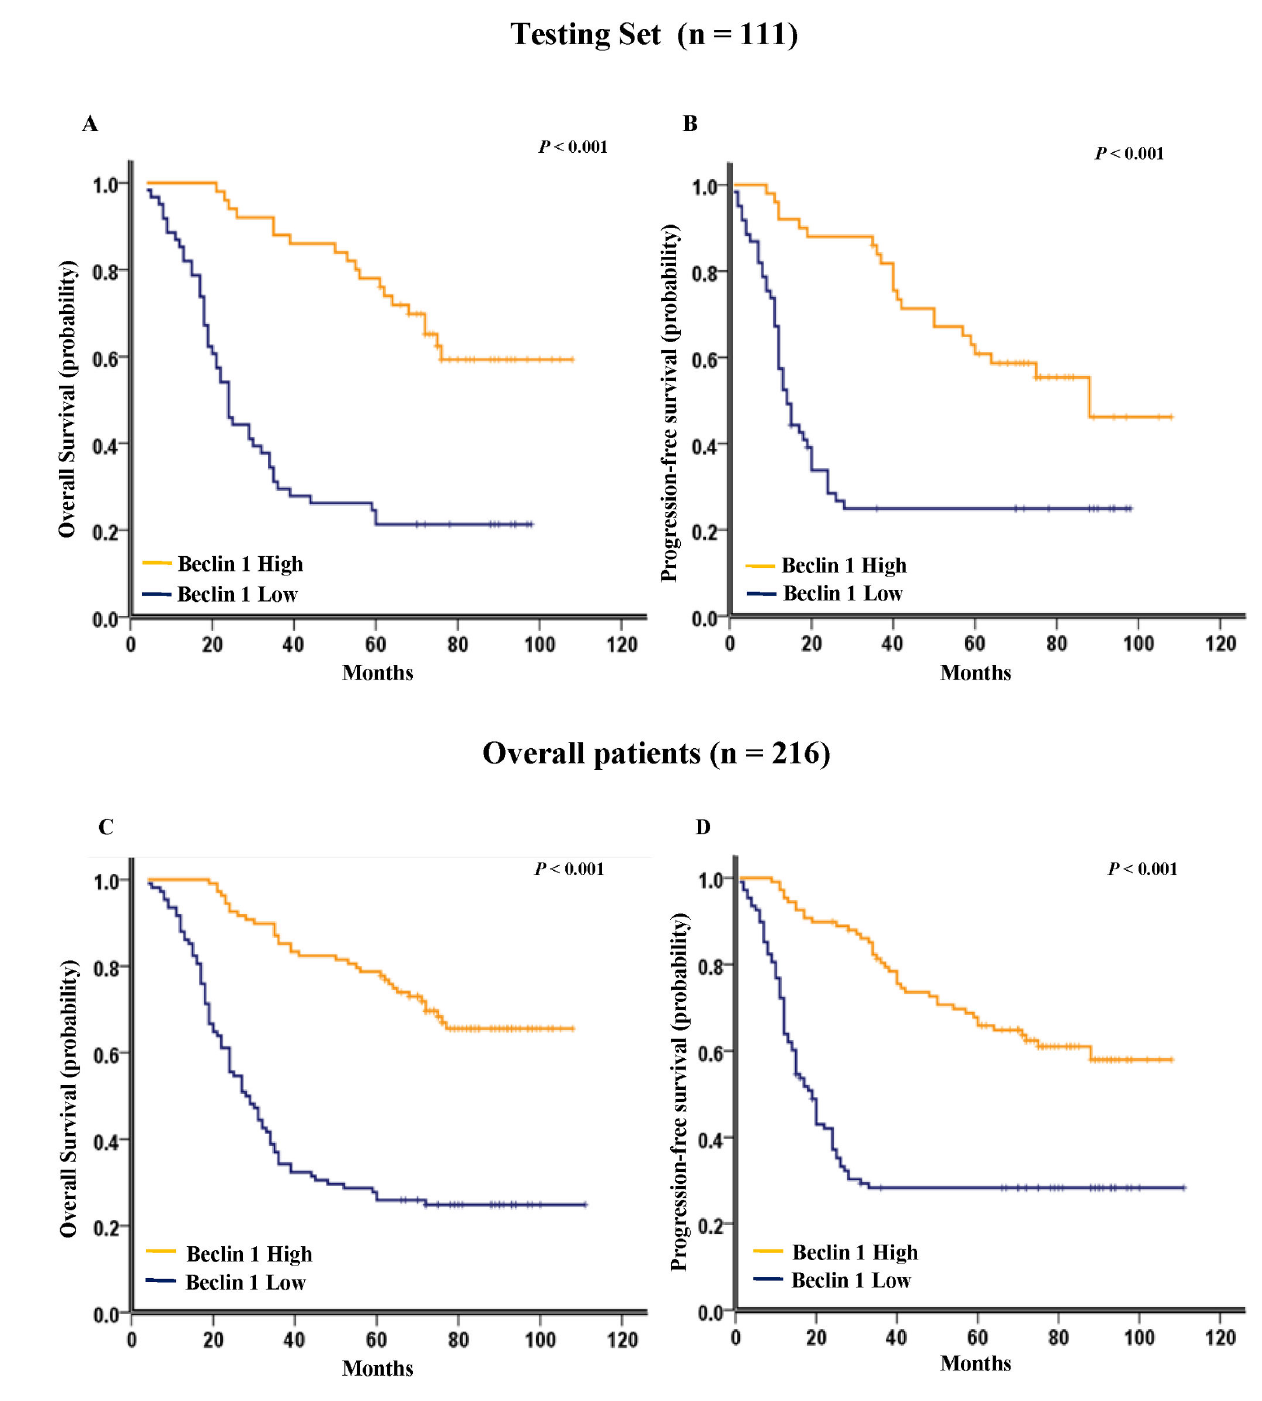
Figure 3. Kaplan-Meier survival analysis of Beclin 1 expression in the testing set and the overall patient cohort. (A) Low expression of Beclin 1 was closely correlated with poor overall survival and (B) progression-free survival in the testing set (n = 111). (C) Patients with lower Beclin 1 expression also acquired an inferior overall survival and (D) progression-free survival in the the overall patient cohort (n = 216). In the testing set and the overall patient cohort, the median duration of overall survival for patients with high and low expression of Beclin 1 was 108 VS. 24.5 months ( p < 0.001) and 108 VS.28 months ( p < 0.001), respectively.